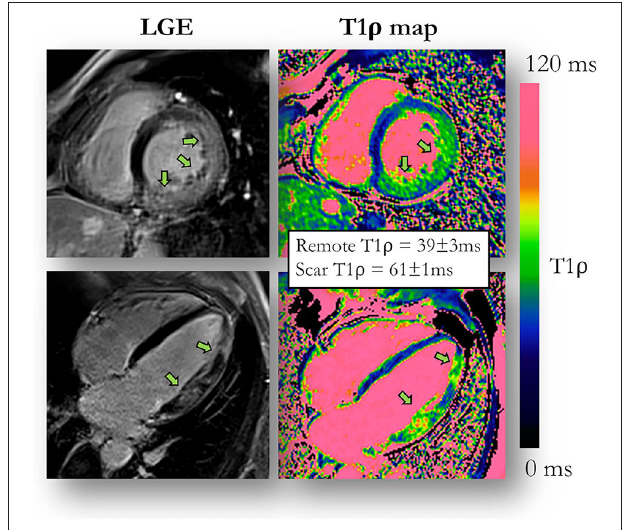
FIGURE 5 | T 1 ρ mapping compared to late gadolinium enhancement (LGE) imaging. An example of a 51-year-old male patient with acute myocarditis and evidence of myocardial injury both on LGE images and contrast-agent-free myocardial T 1 ρ mapping. Adapted with permission from Bustin et al.